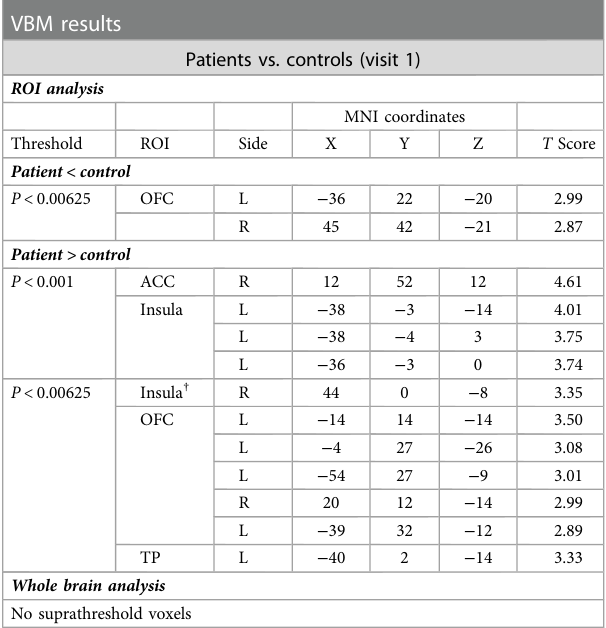
Patients vs. controls (visit 1)